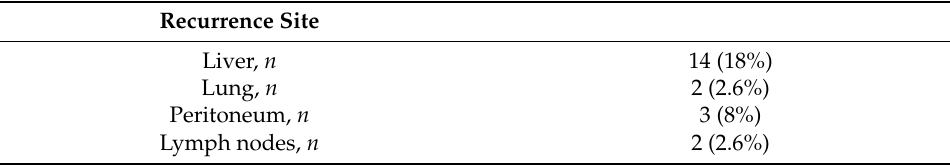
Table 3. Tumor recurrence in the entire study cohort.